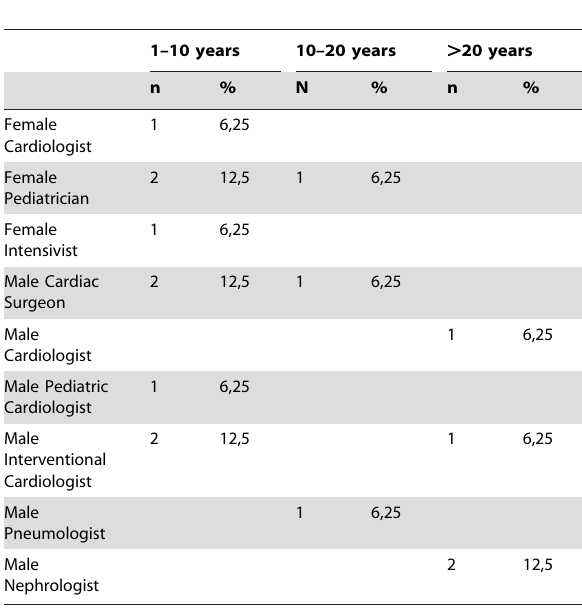
Table 1. Characteristics of participating physicians (gender and specialization X years of